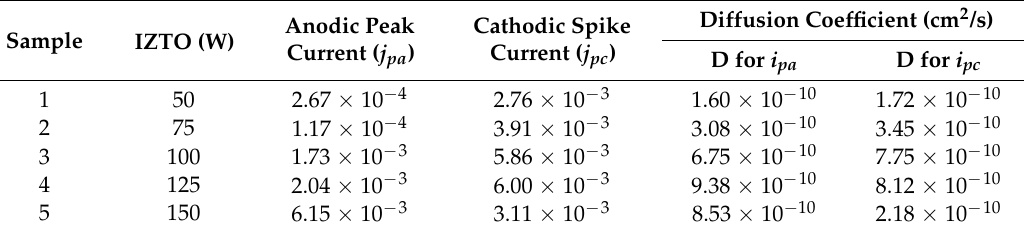
Figure 7. The 50th cycle CV curves of key factor IZTO films with various sputtering powers.